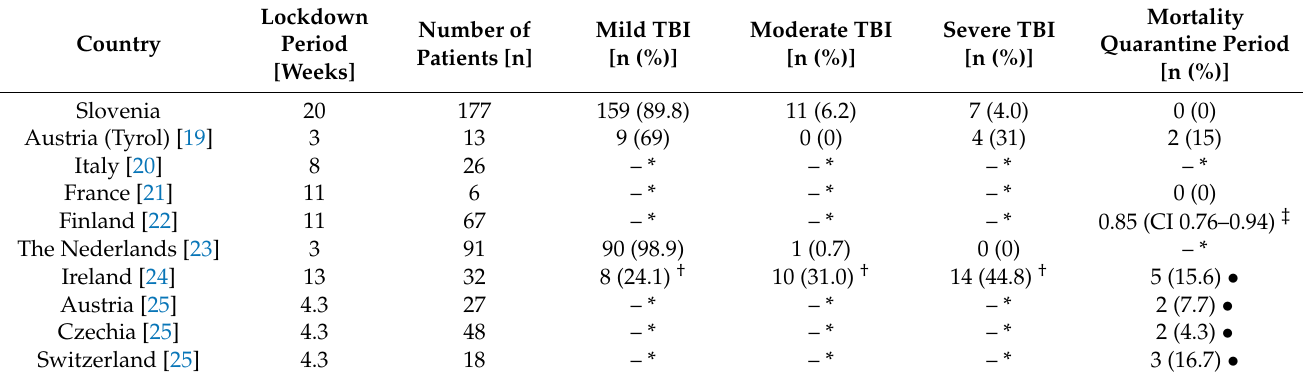
Table 5. Epidemiology of TBI in Central